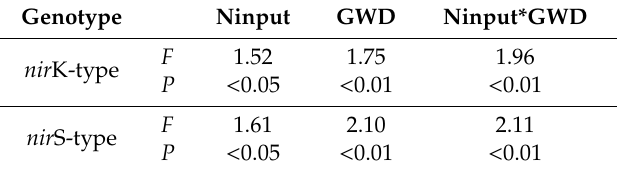
Table 4. E ff ects of depression of groundwater table, reduced nitrogen application and their interactions on the species compositions of nir S-type and nir K-type denitrifier communities.